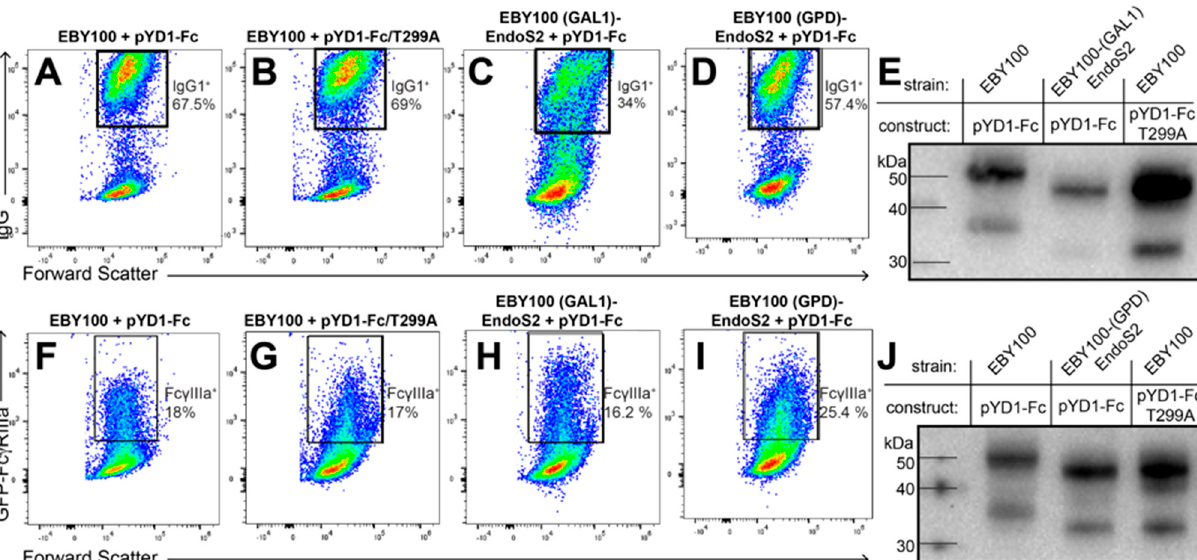
Figure 3. IgG1 Fc display and processing by the EndoS2 yeast strains and the respective controls (pYD1-Fc and pYD1- Fc/T299A). Flow cytometry for IgG1 Fc using an anti-IgG1 antibody ( A – D ) and GFP-Fc γ RIIIa binding ( F – I ). Boundaries for the highlighted boxes were drawn based on negative controls (not shown). ( E , J ) Western blots showing mobility of the Aga2p-IgG1 Fc fusions. T299A is an aglycosylated IgG1 Fc variant which shows reduced binding to GFP-Fc γ RIIIa.